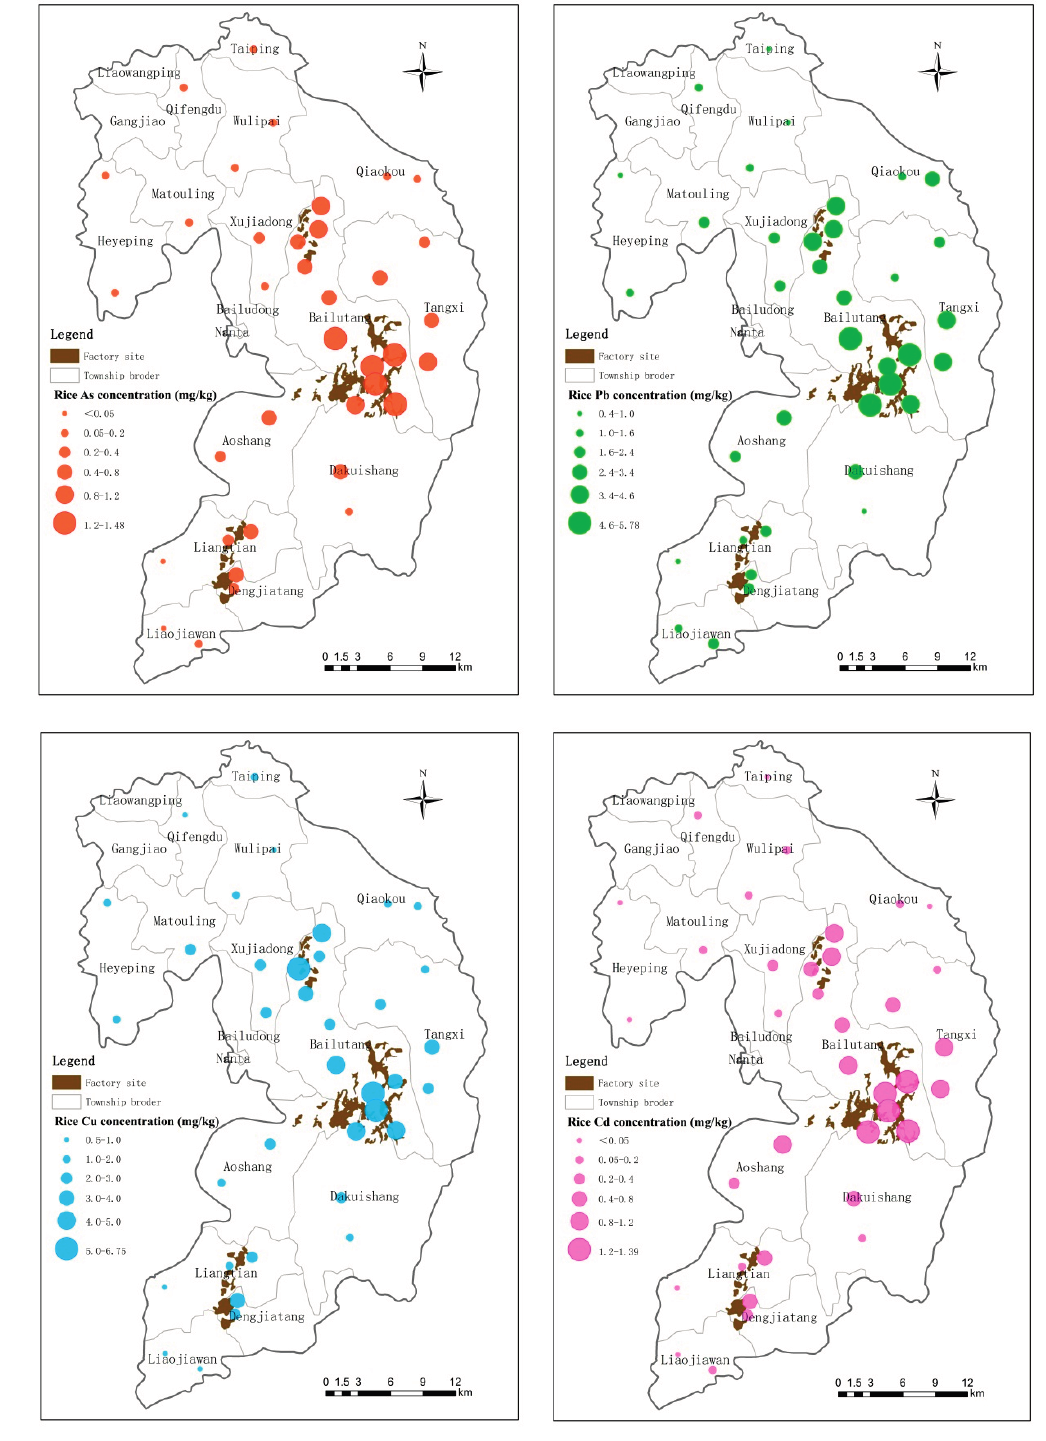
Figure 3. Concentrations of As, Pb, Cu and Cd in rice sampled from the investigated